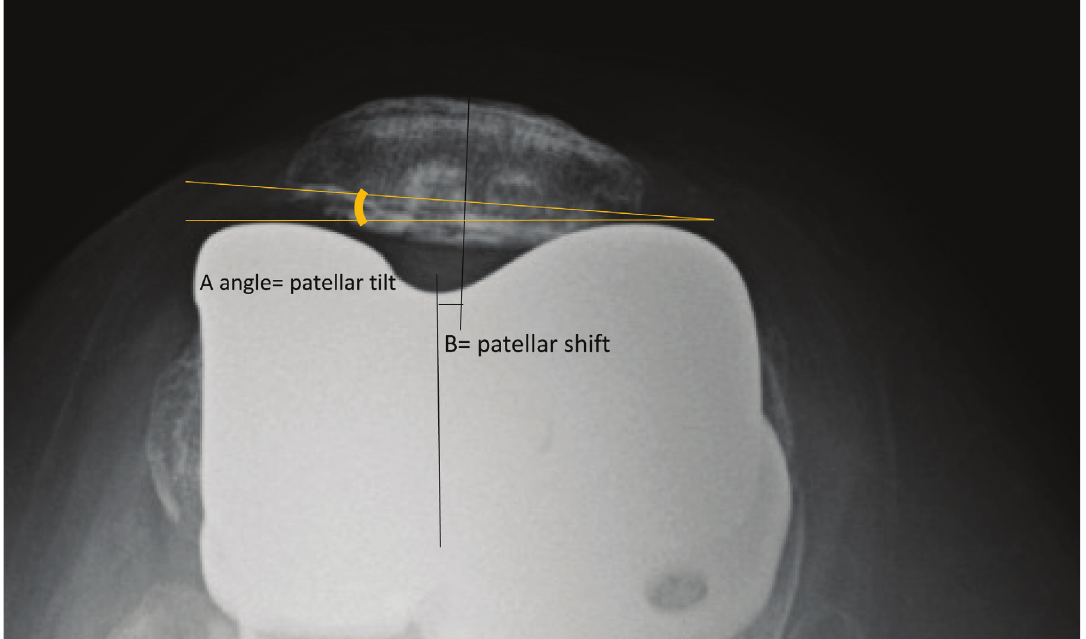
Figure 2. The A angle is patellar tilt. The B distance is patellar shift. It is the distance between center of trochlea of prosthesis and center of patella is patellar shift.